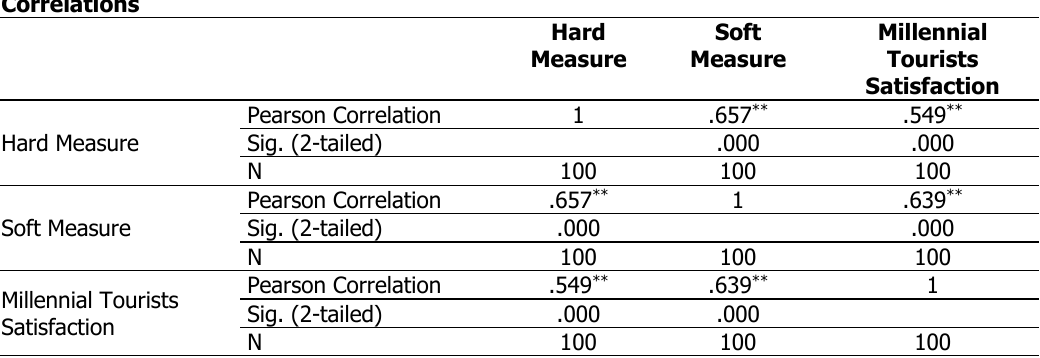
Table 2. Correlation Test